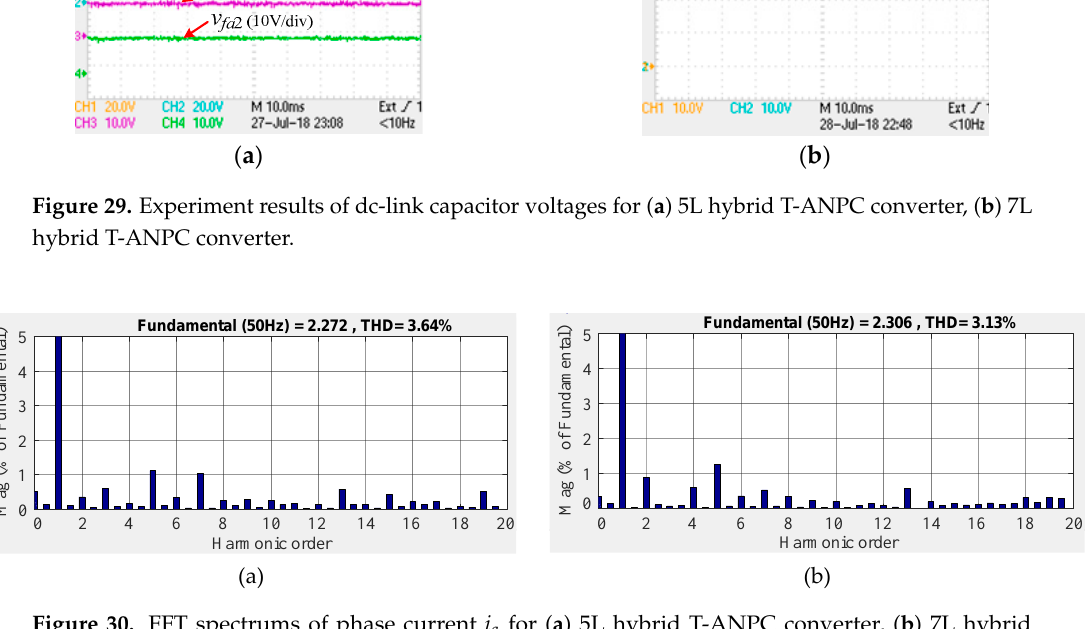
Figure 30. FFT spectrums of phase current i a for ( a ) 5L hybrid T-ANPC converter, ( b ) 7L hybrid T-ANPC converter.